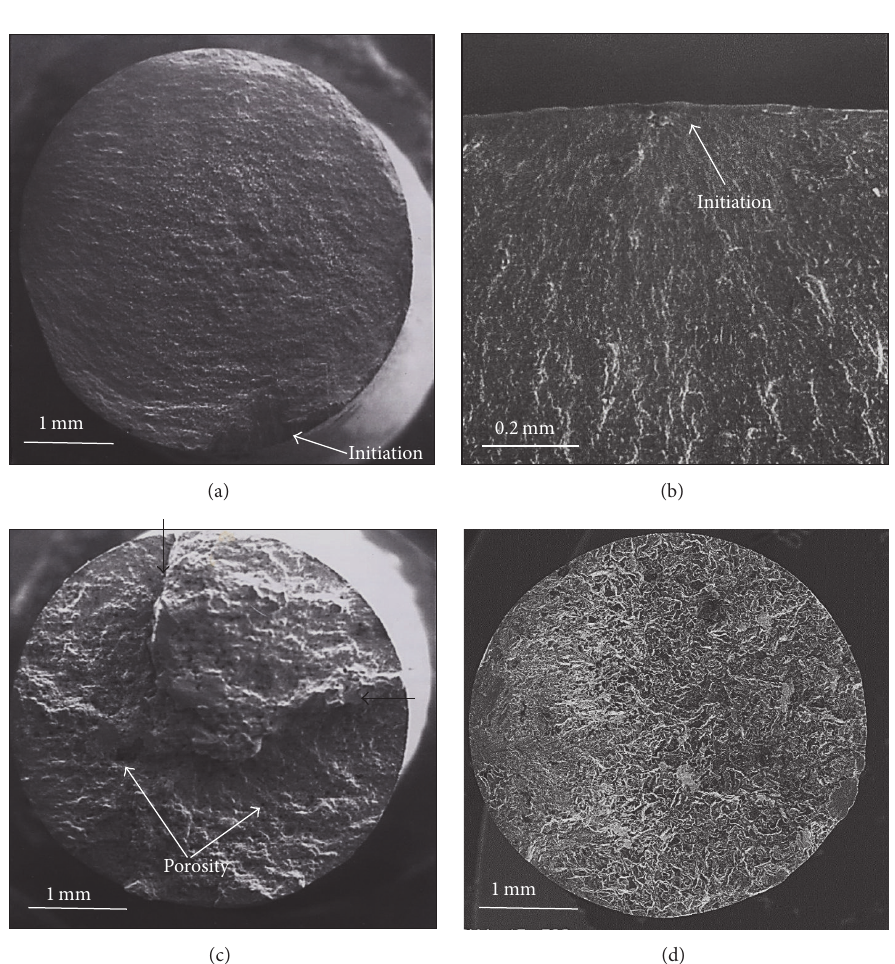
Figure 13: Fracture surface of fatigue samples of DCM3: (a) after solidification, (b) an enlarged image of (a), (c) following solutionizing treatment, and (d) after aging at 220 ∘ C for 20